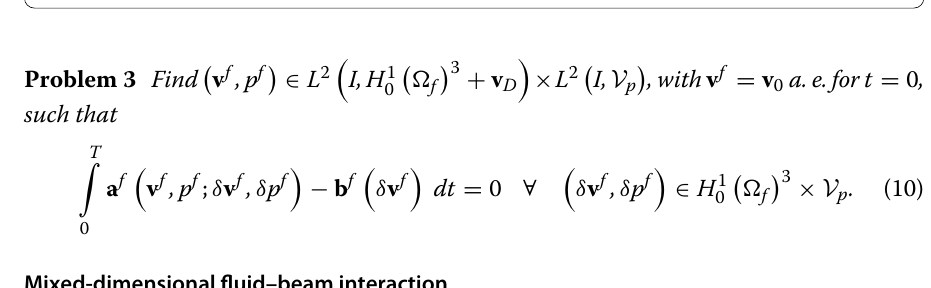
Fig. 2 Domain of a fluid–beam interaction